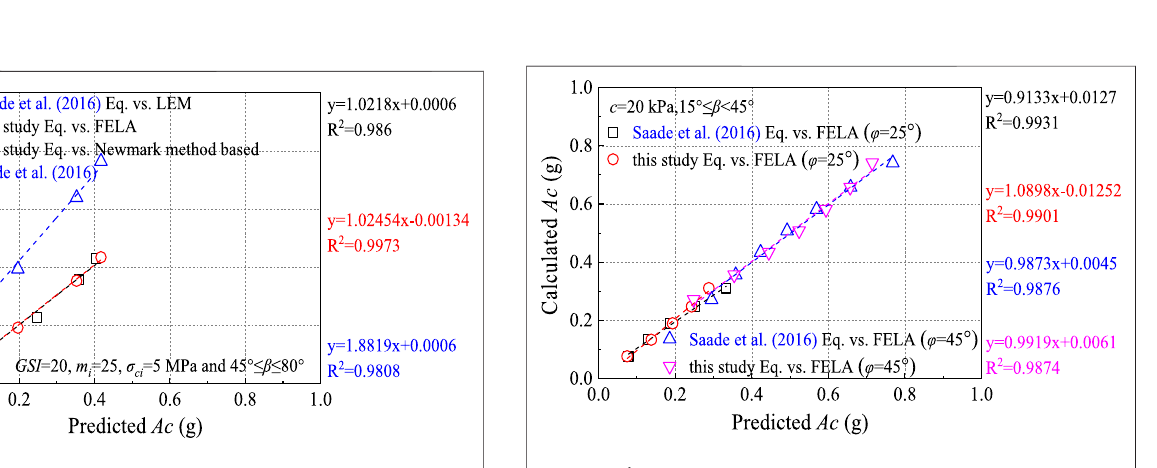
FIGURE 6 | Comparison between the A c values predicted and calculated with the LEM, Newmark method, and FELA for GSI = 20, m i = 25, σ ≤ β ≤ 80 ° . ci = 5 MPa and 45 °